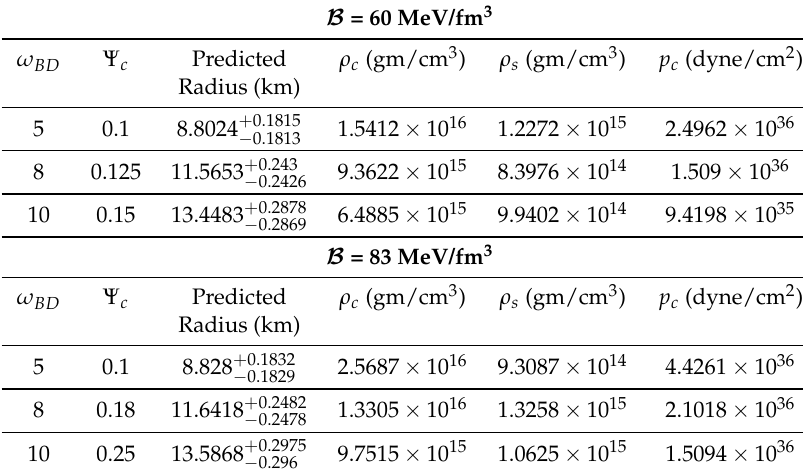
Table 2. Physical properties of PSR J1614-2230 ( M = 1.97 ± 0.04 M (cid:74) ) with m Ψ =